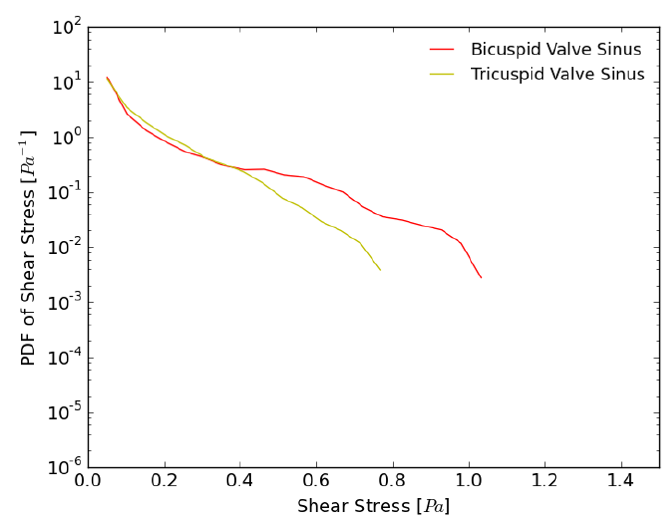
Figure 3. Probability density function in log scale of varying shear stress distribution values along a sub-region near the valve leaflets during systole for the bicuspid and the tricuspid valve sinuses.